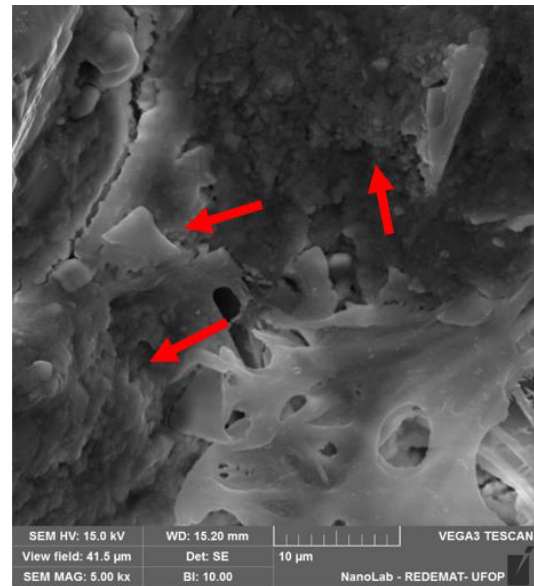
Figure 7. Micrograph of sample AF100-01 tested at 7 days with 5000x magnification.